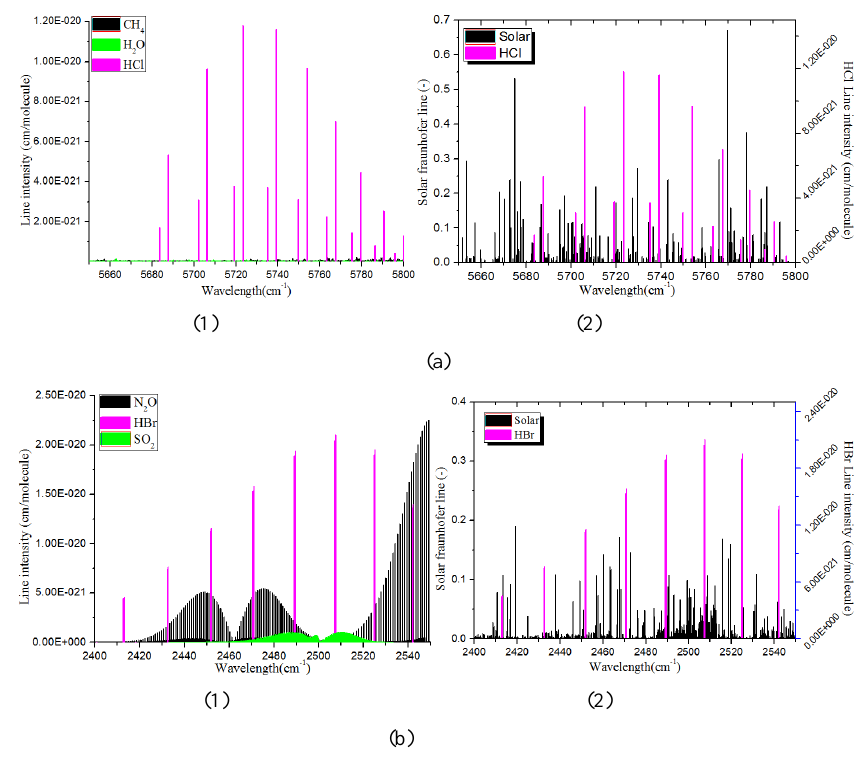
Figure 3. Typical interfering gases and the solar Fraunhofer lines within the HCl and HBr fitting regions. Panel (a1) shows the interfering gases within the HCl fitting regions, (a2) shows the solar Fraunhofer lines within the HCl fitting regions, (b1) shows the interfering gases within the HBr fitting regions, and (b2) shows the solar Fraunhofer lines within the HBr fitting regions. The absorption intensities of all gases are adopted from HITRAN2008. The solar Fraunhofer lines are adopted from the input files of the TCCON software